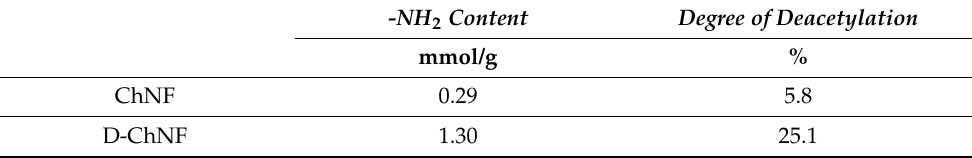
Table 2. Titration analysis to determine the degree of